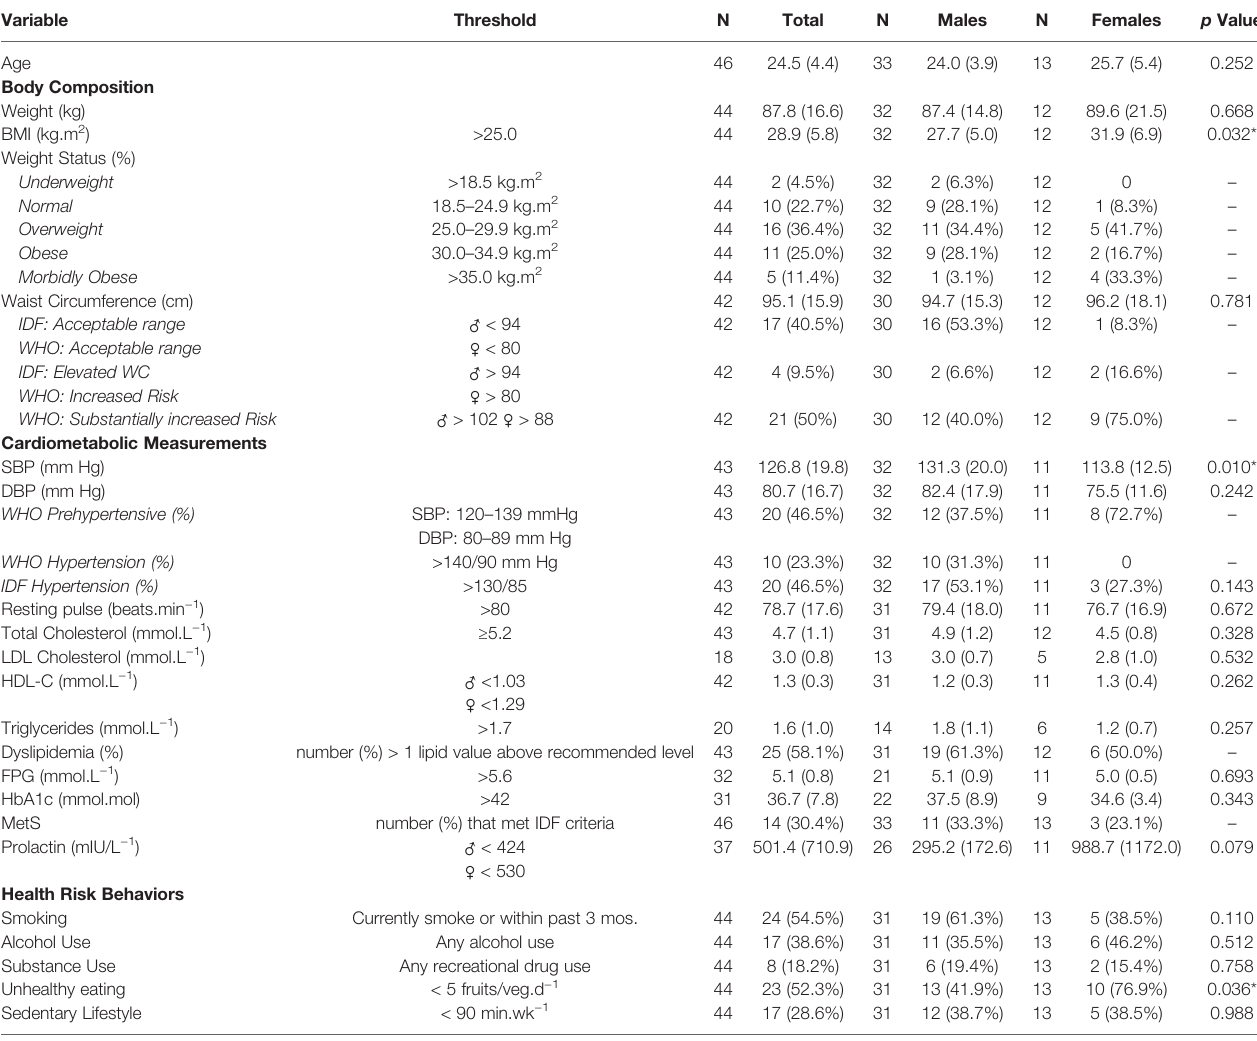
TABLE 2 | Cardiometabolic risk status at baseline by sex.